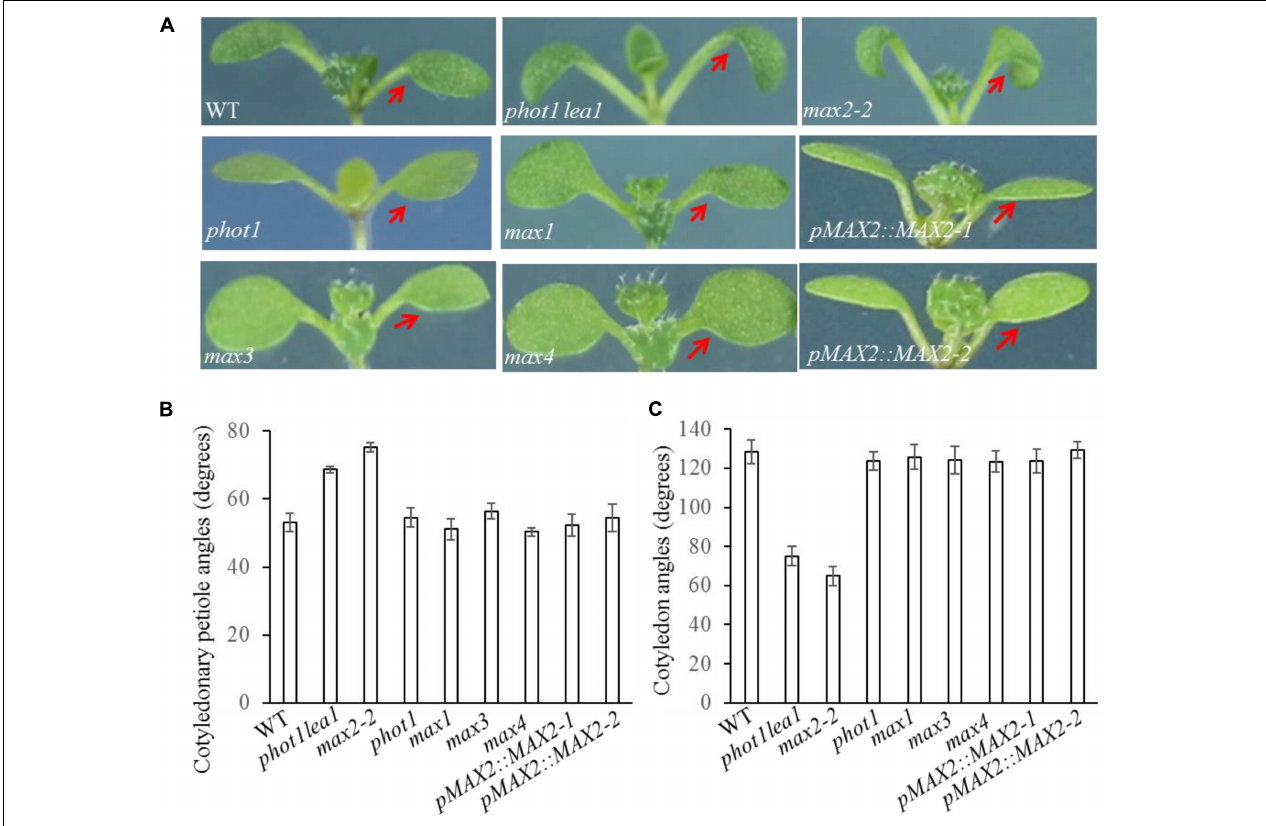
FIGURE 2 | Cotyledon flattening and positioning in the WT, and the phot1 lea1 and max mutants. (A) Cotyledon flattening and positioning of the WT, phot1 lea1 , max mutants, and transgenic plants ( phot1 lea1 mutants with complemented MAX2 expression driven by the native promoter). Red arrows indicate the cotyledons. (B) Cotyledonary petiole angles of seedlings represented in panel (A) . (C) Cotyledon angles of seedlings represented in panel (A) . Each bar represents an average of three experiments (15–20 measurements per experiment) ±